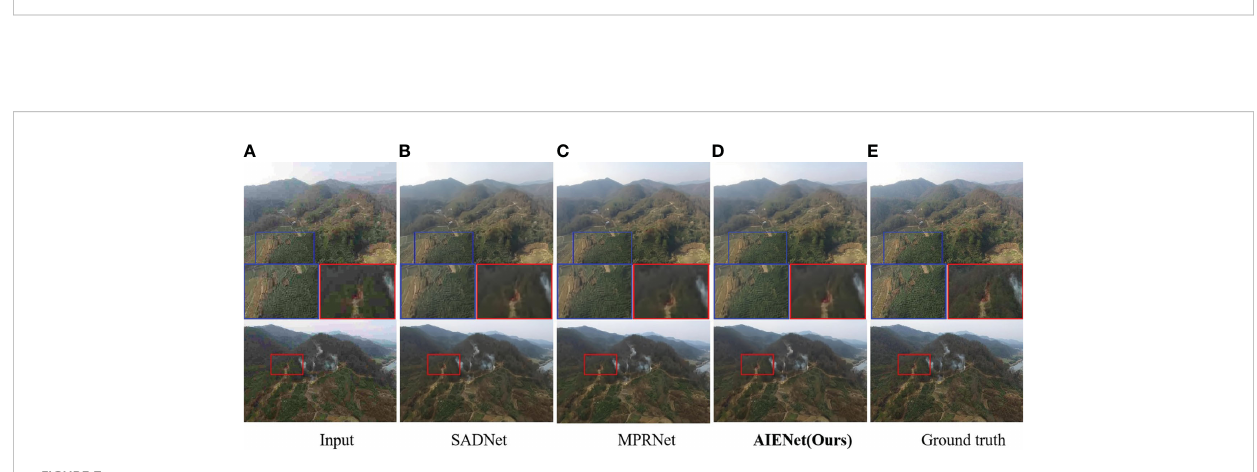
FIGURE 6 Qualitative enhancement comparisons of our model on synthetic motion blur samples with MIMO-UNet (Cho et al., 2021) and DMPHN (Zhang et al., 2019). (A) is the input motion blur images, (B, C) are the enhancement results of the state-of-the-art algorithms, (D) is the enhancement results of the proposed AIENet, and (E) is the ground truth images. Blue and red boxes correspond to the zoomed-in patch for better comparison.